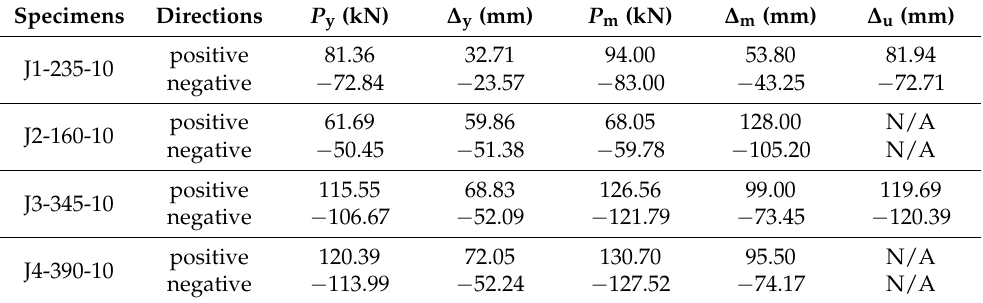
Table 5. Critical points of the skeleton